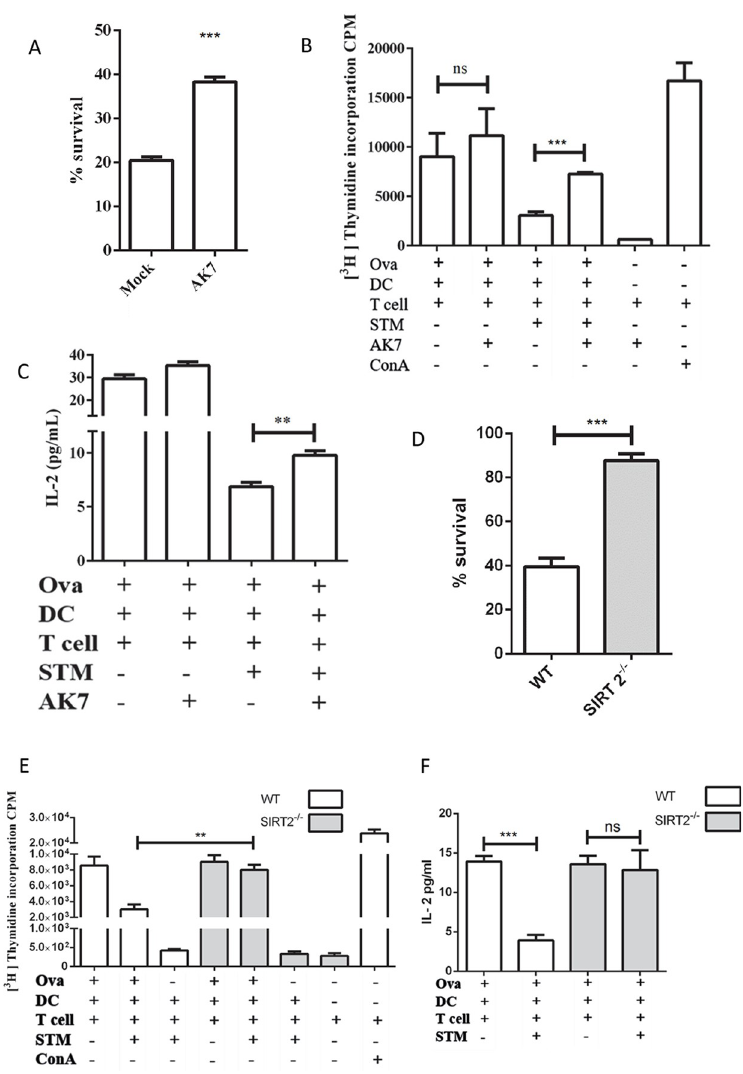
Fig 2. Inhibition of SIRT2 enhances intracellular bacterial survival and CD8 + T cell response. A. Percentage survival of intracellular Salmonella in DCs in gentamicin protection assay in the presence and absence of SIRT2 inhibitor, AK7. (Mock- DMSO treated, AK7- 10 μ M AK7 treated). (Data are presented as mean ± SEM of 4 independent experiments) B. 3 [H] Thymidine incorporation to assess CD8 + T cells proliferation during Salmonella infection in response to SIRT2 inhibition. (Ova- Ovalbumin, DC- Dendritic cells, T cell- mixed lymphocyte, STM- Salmonella Typhimurium, AK7- 10 μ M AK7, ConA- Concanavalin A) (Data are presented as mean ± SEM of 3 independent experiments) C. IL-2 levels during CD8 + T cells proliferation assay during Salmonella infection in response to SIRT2 inhibition. (Ova- Ovalbumin, DC- Dendritic cells, T cell- mixed lymphocyte, STM- Salmonella Typhimurium) (Data are presented as mean ± SEM of 2 independent experiments) D. Percentage survival of intracellular Salmonella in DCs in gentamicin protection assay in wild type and SIRT -/- DCs. (Data are presented as mean ± SEM of 3 independent experiments) E. 3 [H] Thymidine incorporation to assess CD8 + T cells proliferation during Salmonella infection in wild type and SIRT2 -/- DCs. (Ova- Ovalbumin, DC- Dendritic cells, T cells- mixed lymphocyte, STM- Salmonella Typhimurium, ConA- Concanavalin A) (Data are presented as mean ± SEM of 3 independent experiments) F. IL-2 levels during CD8 + T cells proliferation assay in response to Salmonella infection in wild type and SIRT2 -/- DCs. (Ova- Ovalbumin, DC- Dendritic cells, T cells- mixed lymphocyte, STM- Salmonella Typhimurium) (Data are presented as mean ± SEM of 2 independent experiments) (unpaired two-tailed Student’s t- test, p- value, ��� < 0.0001, �� < 0.001, � < 0.01).